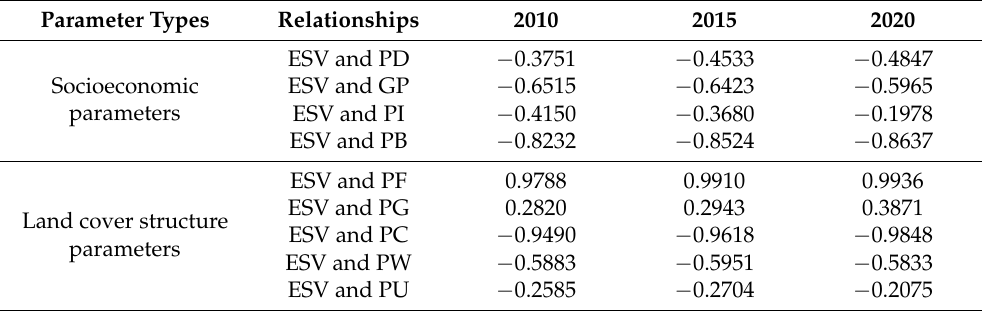
Table 5. Correlation coefficients between ecosystem service value and socioeconomic